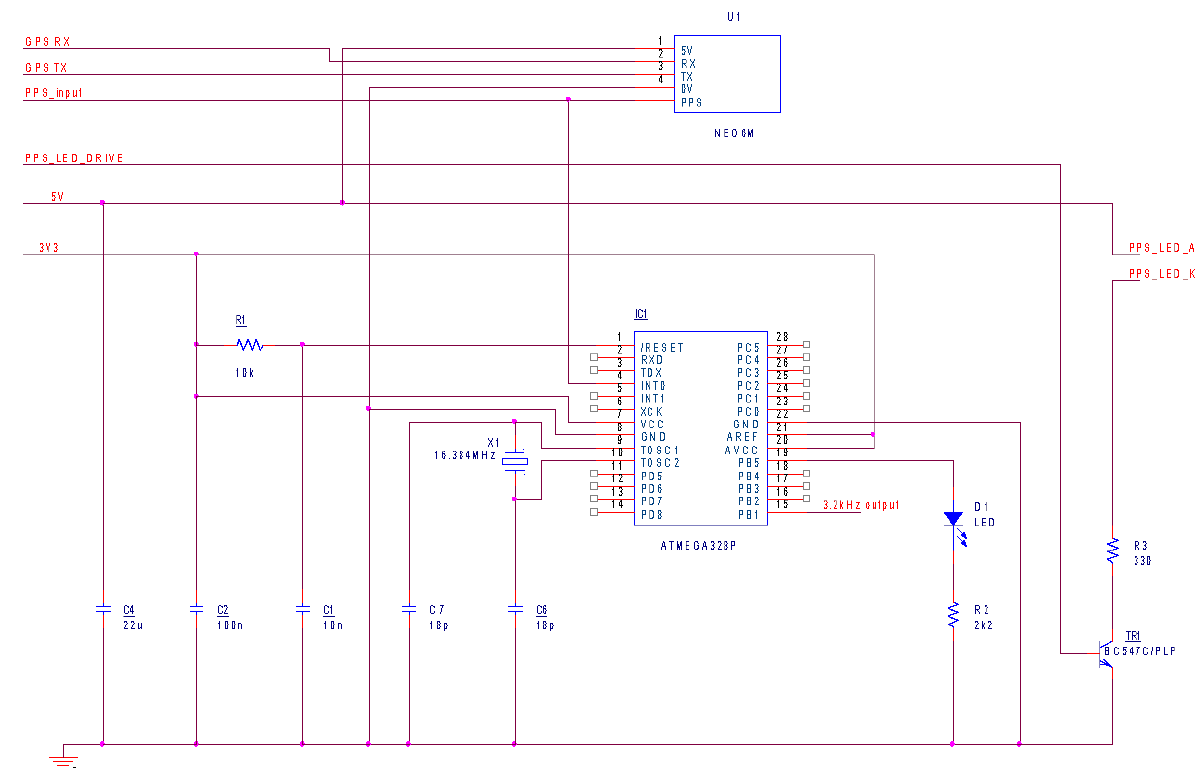
Figure 19. GPS receiver module and PPS acquisition circuit.